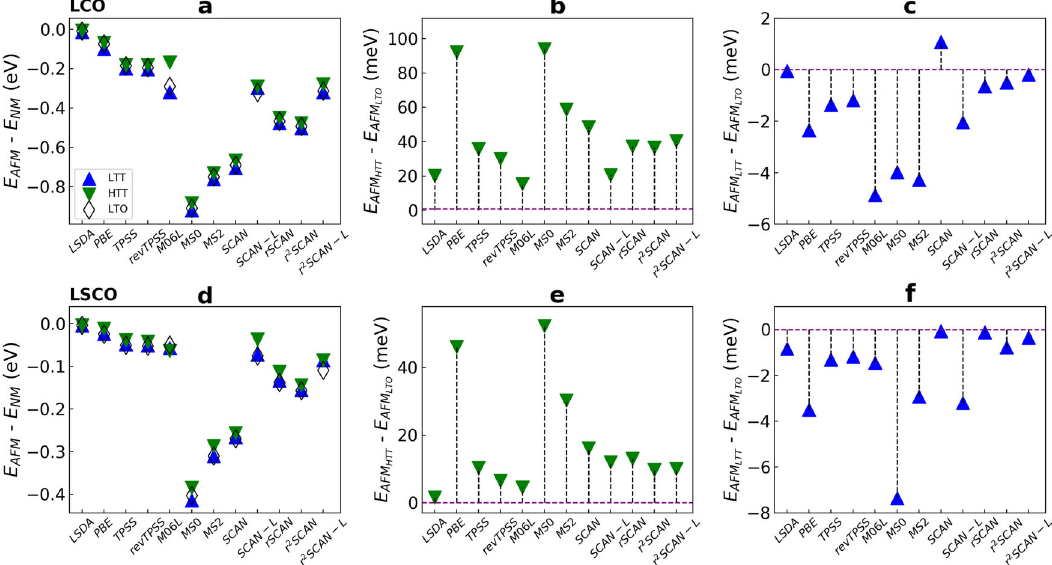
Fig. 2 Various energy calculations obtained for all three phases using different DFAs. a Energy differences between the G-AFM and NM phases for the HTT (green upside-down triangle), LTO (white diamond), and LTT (blue triangle) structures for various XC density functionals. b , c Relative energies per formula unit for AFM in pristine LCO between LTO and HTT ( b ) and LTO and LTT ( c ). d – f Same as a – c except that these panels refer to LSCO instead of